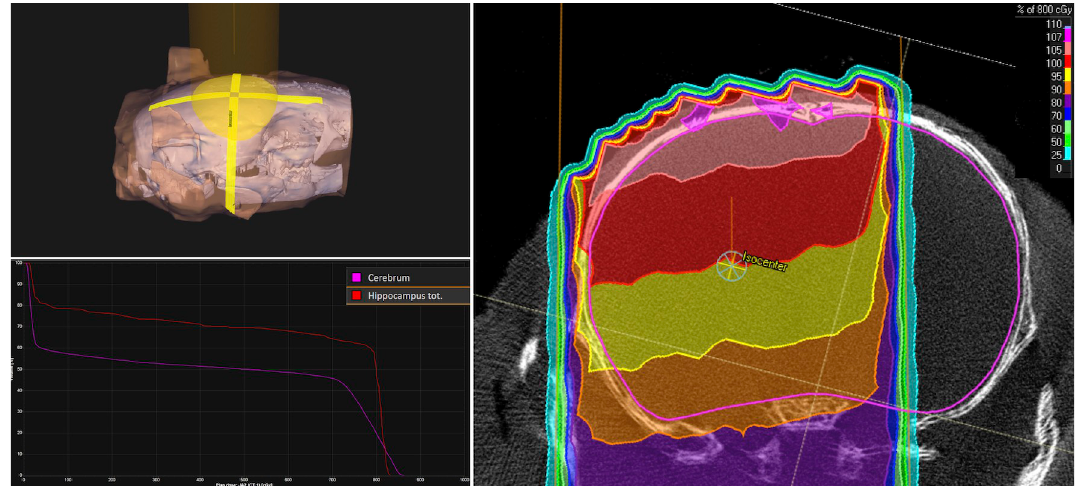
Fig 4. The reconstructed treatment set-up in the microRayStation treatment planning system, with the isocenter positioned at the point of the tumor cell inoculation. The upper left panel shows the orientation of the posterior radiation beam (10 mm field size) relative to a 3D rendering of the rat skull, with a semi-transparent skin contour and the cranium in white. The right panel shows the resulting dose distribution in an axial slice through the isocenter. The color shades illustrate the percentage dose levels relative to the 8 Gy prescribed dose to the isocenter. The lower left panel shows the dose-volume histograms for the cerebrum and the hippocampi.